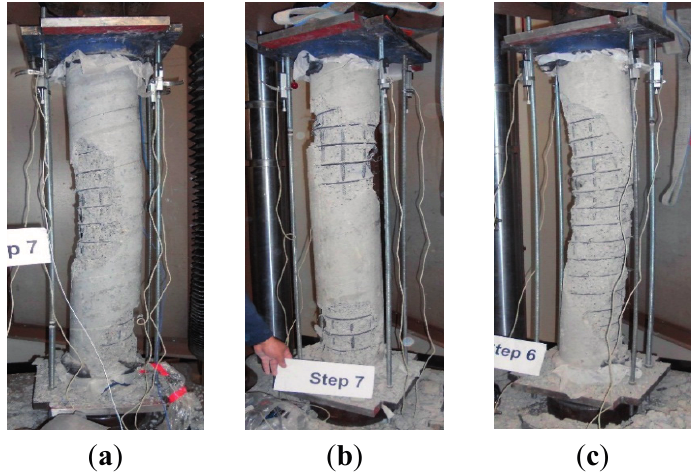
Figure 16. Failure modes of RC-benchmark ( a ); 1-Hr ( b ); and 2-Hr ( c ) exposure columns.